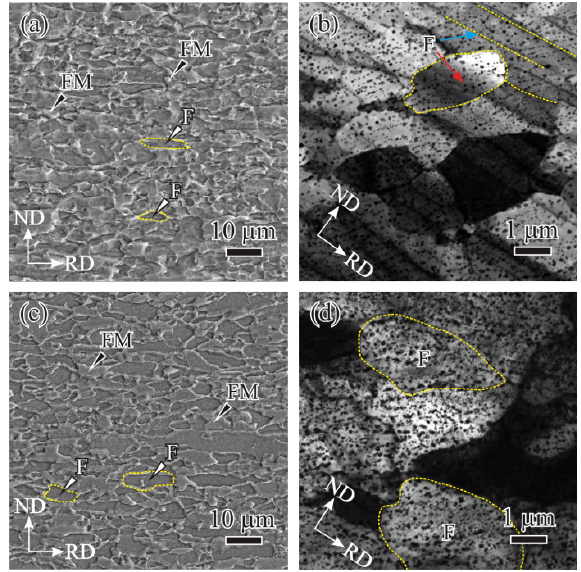
Figure 3. SEM and corresponding TEM images of quenched microstructure after inter-critical holding at 755 °C for ( a , b ) 180 s and ( c , d ) 240 s.